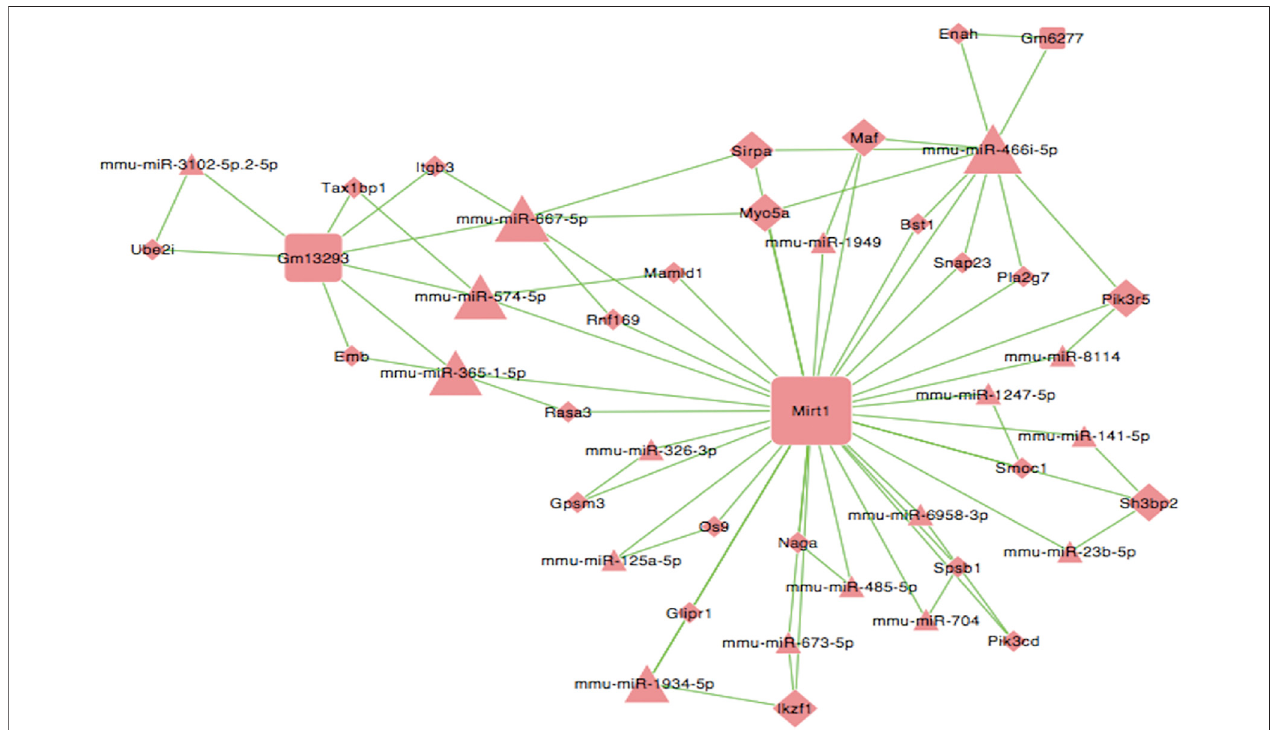
FIGURE 8 | LncRNA – miRNA – mRNA ceRNA network. Square nodes represent lncRNAs, triangle nodes represent microRNAs, and rhombus nodes represent mRNAs. The lines between nodes indicate a correlation. The size of node represents the correlation